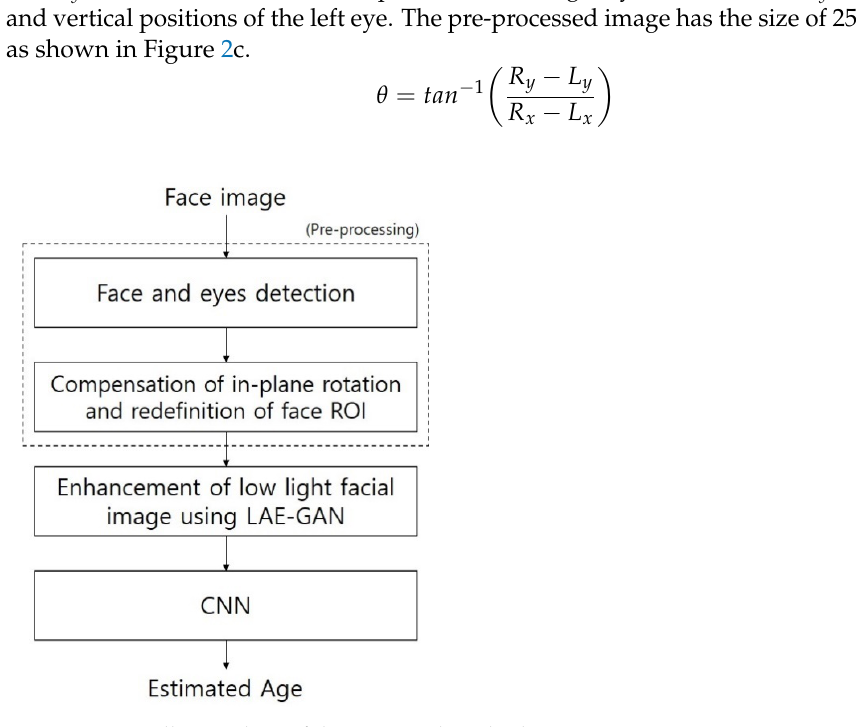
Figure 1. Overall procedure of the proposed method.